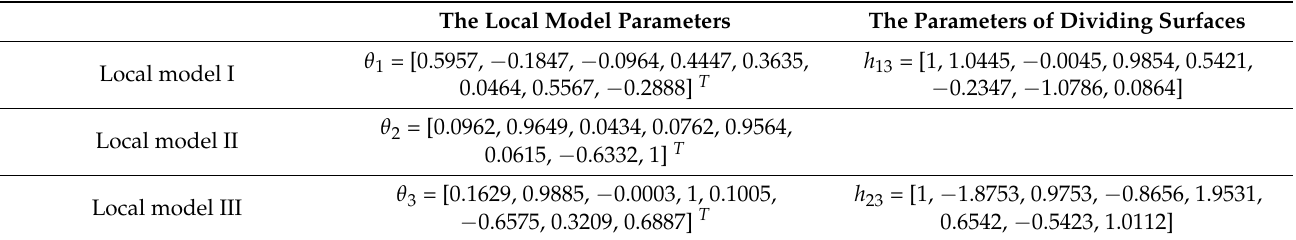
Table 1. Local moel modeling parameters. The Local Model Parameters The Parameters of Dividing